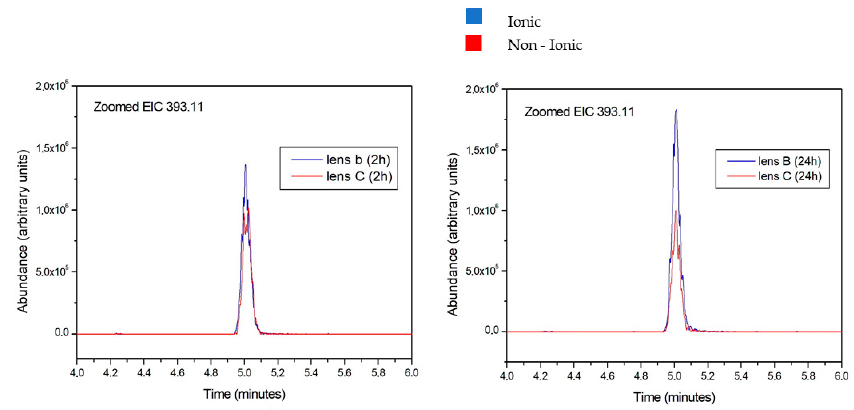
Figure 4. Aloesin amount released from ionic and non-ionic lens after 2 and 24 h. The blue peak overwhelms the red peak at all tested times, thus indicating the more abundant release of aloesin from the ionic lens compared to the non-ionic lens.